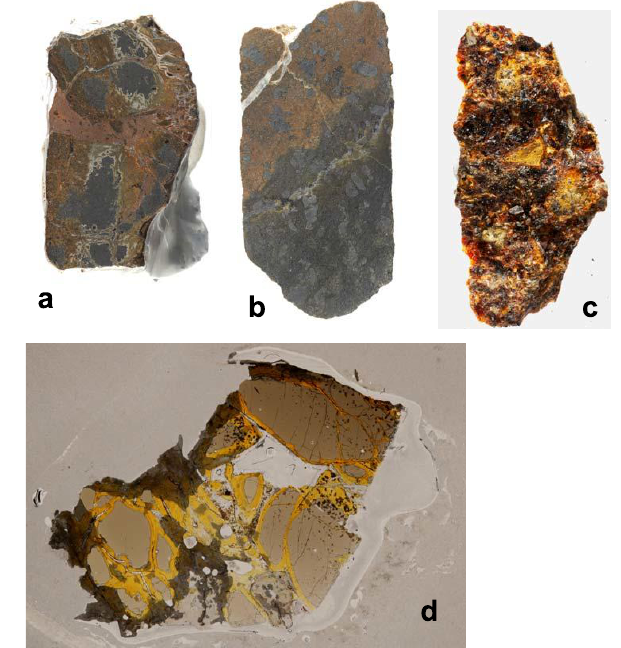
Figure 2. (a) Photograph of sample U1382A-5R-1, 116–119cm, a strongly altered hyaloclastite (length of piece: 3cm). (b) Pho- tograph of sample U1382A-8R-4, 50–63cm, a strongly serpen- tinized mantle peridotite with an oxidation halo along a prominent aragonite vein (length of piece: 13cm). (c) Photograph of sample U1383C-17R-1, 120–123cm, a strongly altered hyaloclastite dedi- cated for microbiological studies (length of piece: 3cm) (d) Thin section photomicrograph (Sample U1383C-20R-1, 111–113cm) showing glassy to spherulitic fragments of a hyaloclastite with pro- nounced palagonite rims (brown) and zeolite (colorless) filling void space. Width of image is 1.2cm.